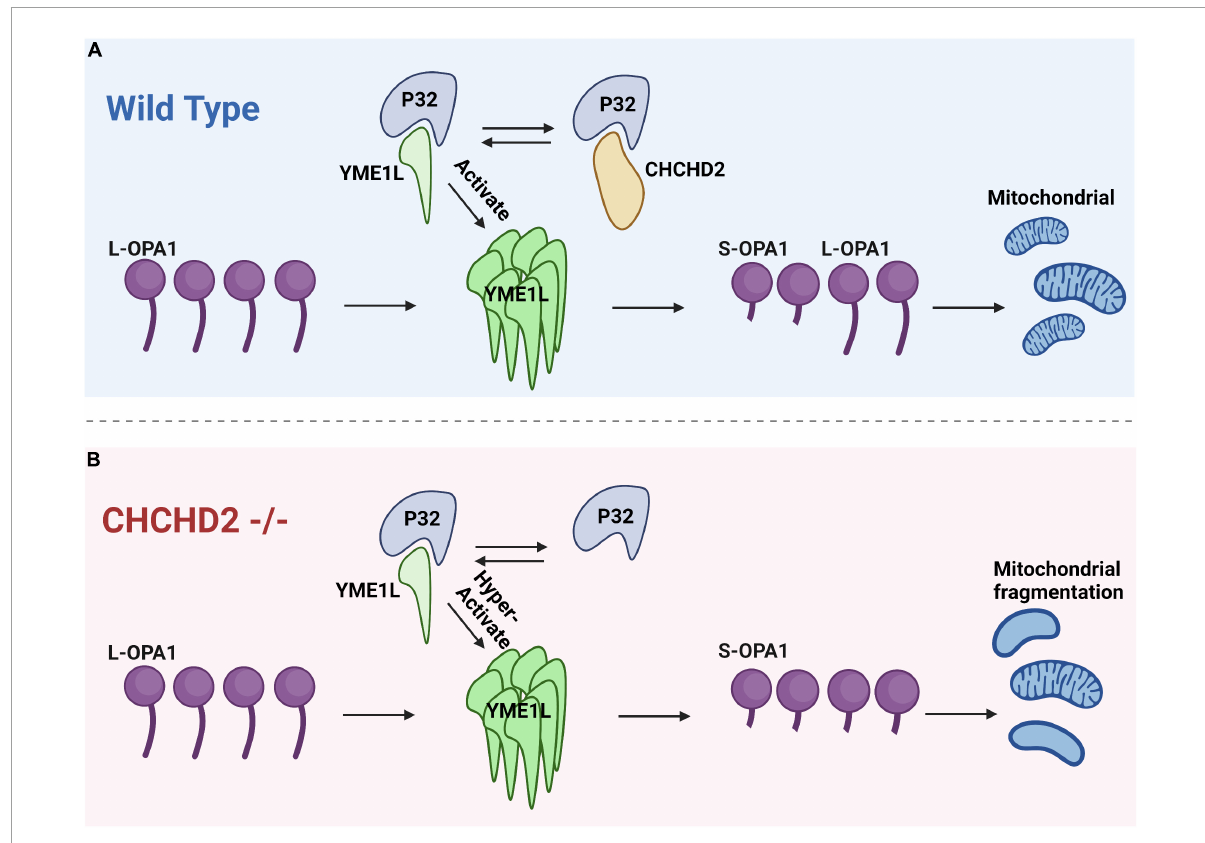
FIGURE3 The interaction between CHCHD2 and P32 regulates the levels of OPA1 to modulate mitochondrial fission. (A) In the wild type groups, P32 binds to CHCHD2 and YME1L. The interaction between P32 and YME1L enhances OPA1 degradation. CHCHD2 competes with YME1L for P32, and as a result, OPA1 levels are maintained. (B) In CHCHD2 mutants, YME1L has access to a greater quantity of P32, which facilitates the degradation of OPA1 and leads to mitochondrial fragmentation.